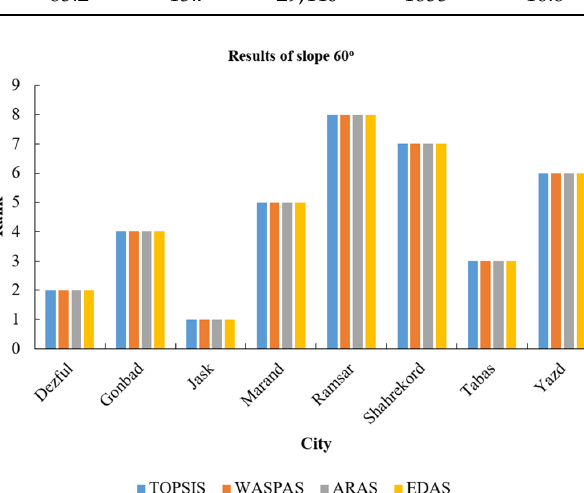
Tabas were all selected as the most suitable cities in all four techniques. The results of the ranking are compared in Figure 13. An interesting point that can be seen from Figure 13 is that for a 60° angle, the first and second ranks (Jask and Dezful) are the same as the 0° and 30° angles, but the third-most suitable city is Tabas (instead of Gonbad).